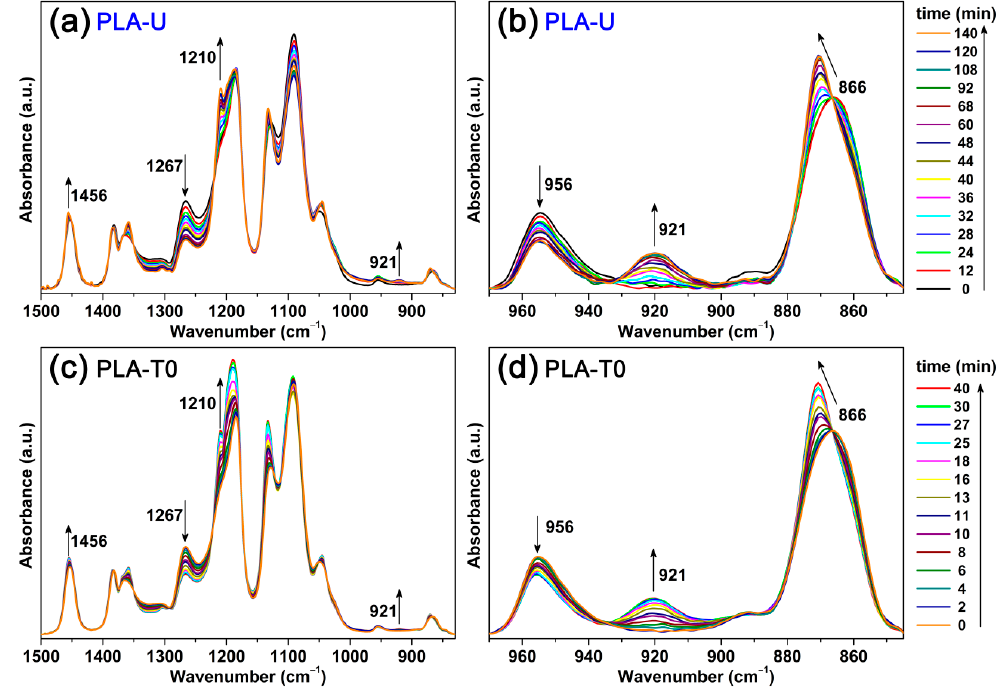
Figure 3. Time-resolved FTIR spectra in the 1500 − 830 cm − 1 ( a , c ) and 970 − 850 cm − 1 ( b , d ) ranges for PLA-U ( a , b ) and PLA-T0 ( c , d ) during the isothermal crystallization at 110 °C.